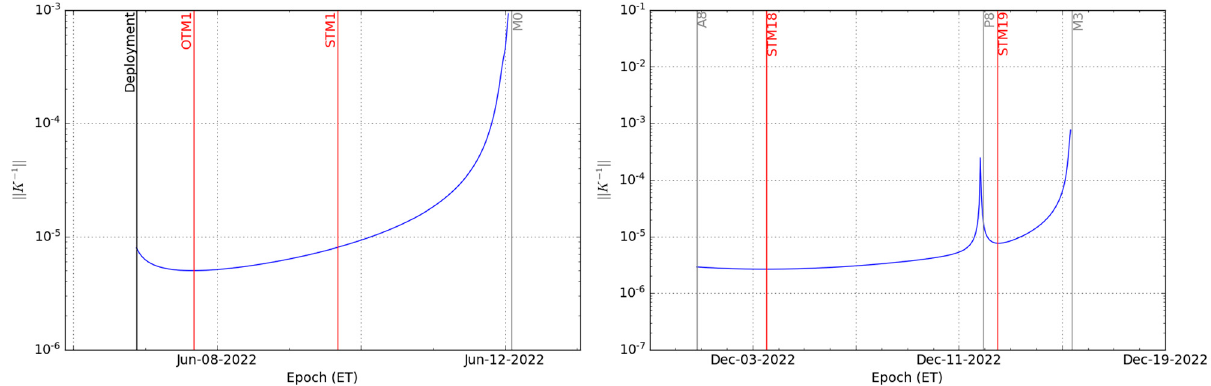
Figure 6. K-inverse norm evolution for the targeting of B.R, B.T and LTOF coordinates of the B-Plane for the fly-bys M0 ( left ) and M3 ( right